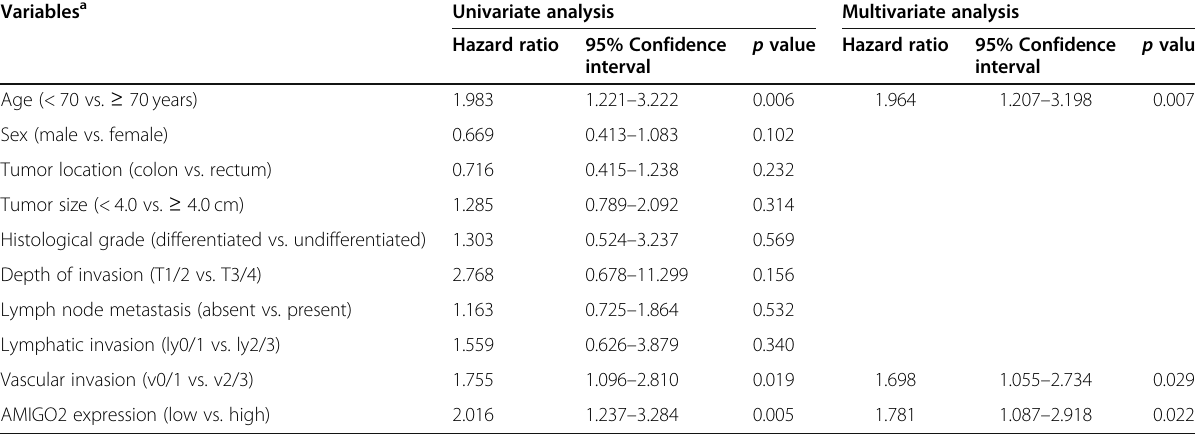
Table 2 Univariate and multivariate analysis for overall survival in CRC patients (Cox proportional hazard regression model) Variables a